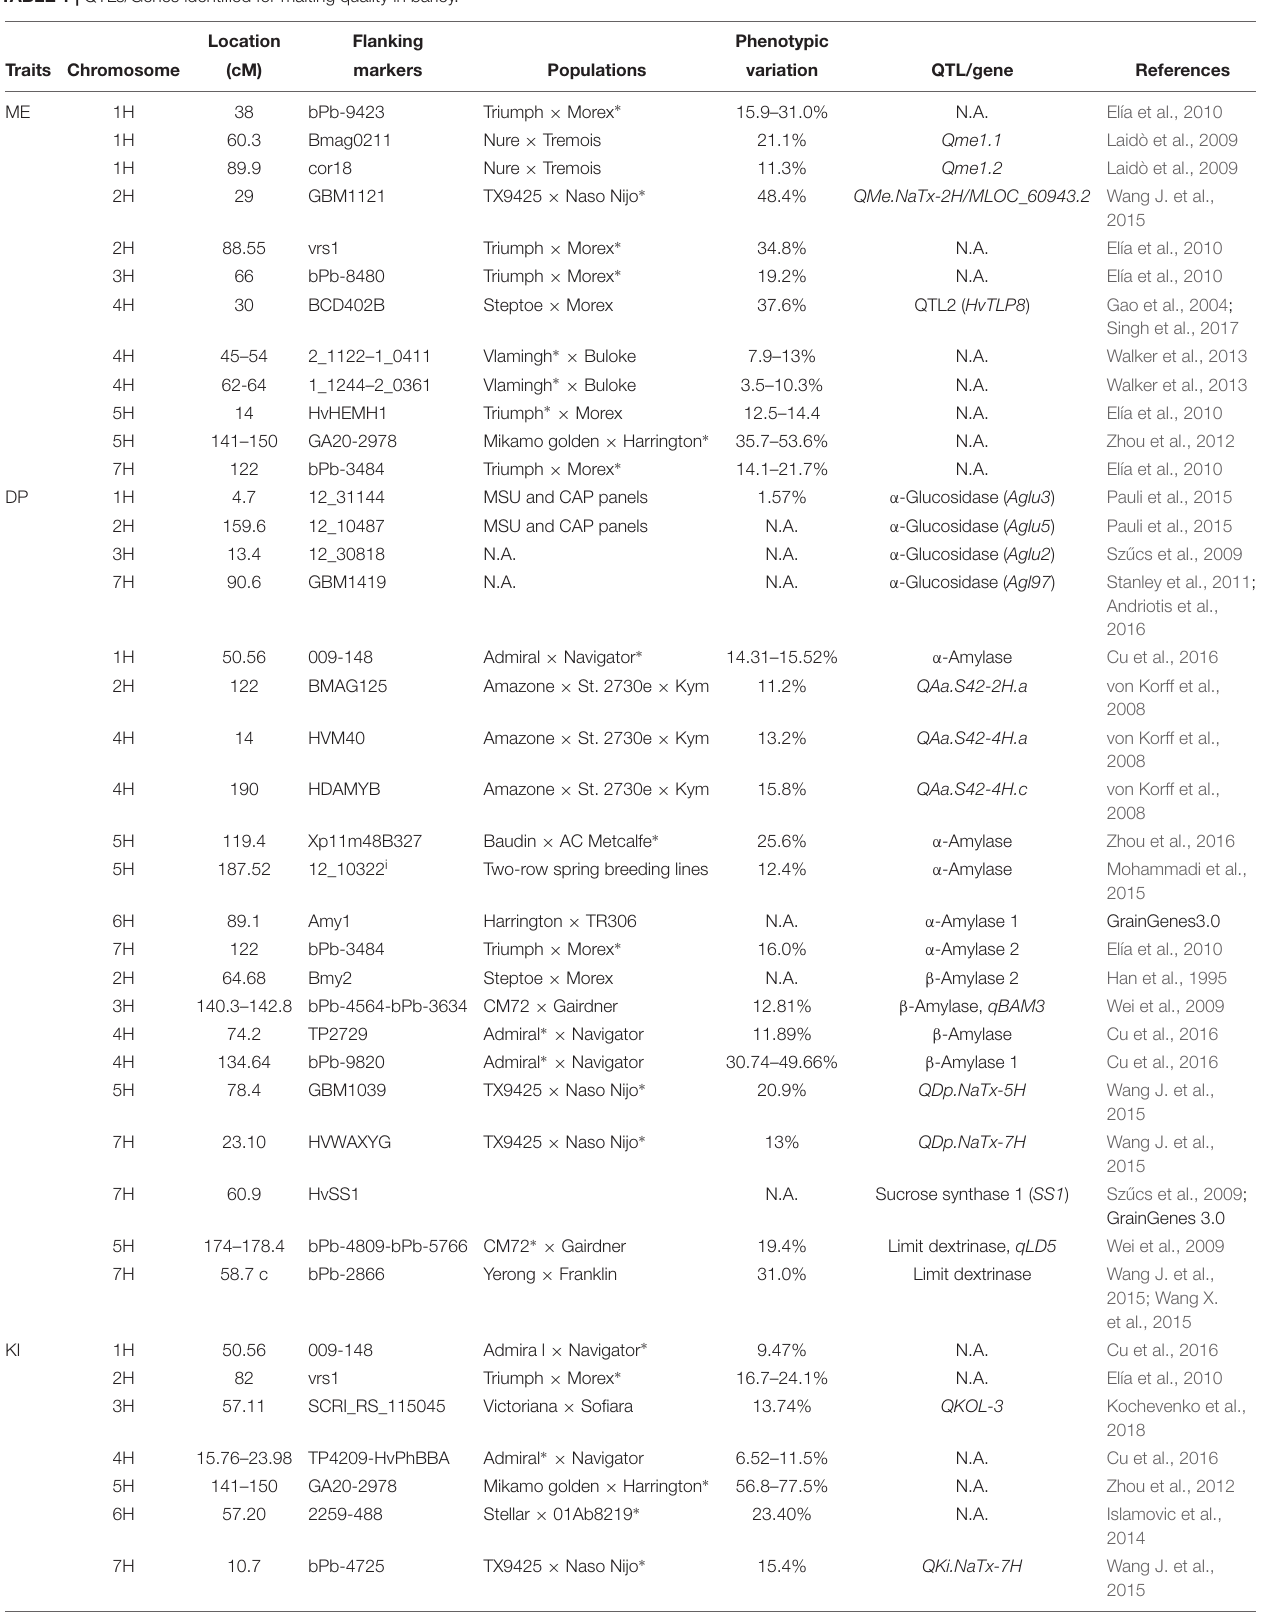
TABLE 1 | QTLs/Genes identified for malting quality in